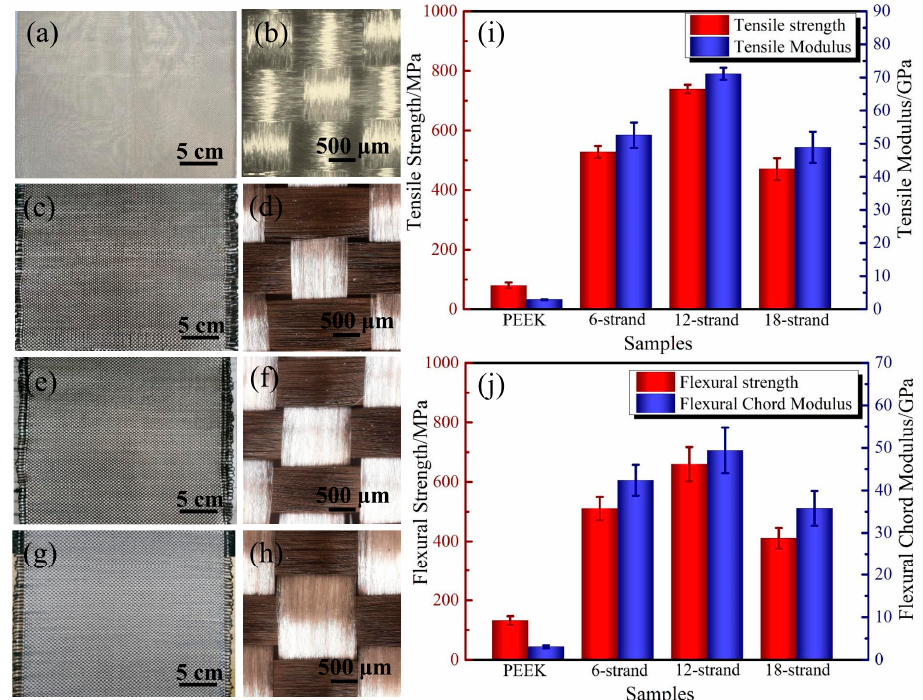
Figure 8. Surface morphology of PEEK and CF/PEEK plain weave fabrics of different contents and the mechanical properties of composites: ( a ) PEEK plain weave fabrics; ( b ) PEEK plain weave fabrics; ( c ) plain weave fabrics with 6-strand PEEK fibers; ( d ) plain weave fabrics with 6-strand PEEK fibers; ( e ) plain weave fabrics with 12-strand PEEK fibers; ( f ) plain weave fabrics with 12-strand PEEK fibers; ( g ) plain weave fabrics with 18-strand PEEK fibers; ( h ) plain weave fabrics with 18-strand PEEK fibers; ( i ) the tensile strength and modulus and ( j ) the flexural strength and modulus. Table 3. Longitudinal and transverse tensile properties of CF/PEEK unidirectional plates at different isothermal temperatures. ( σ t is the tensile strength; E t is the tensile modulus; σ f is the tensile strength; E f is the tensile modulus).